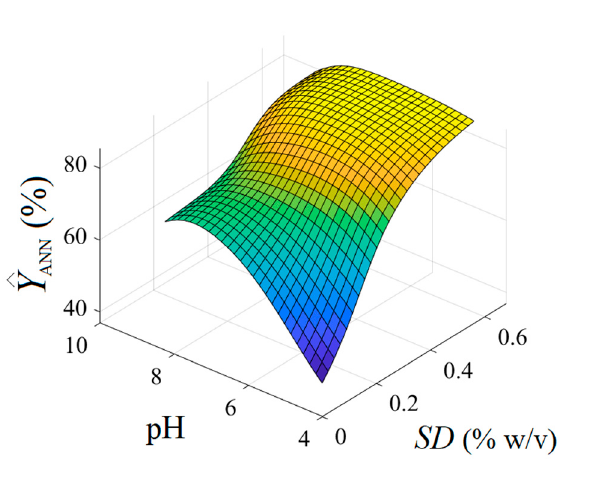
Figure 6. Predictions given by feed forward ANN model showing the estimated response (𝑌 depending on pH and SD (g/L) factors: ( a ) 3D output surface, and ( b ) 2D contour-lines map.